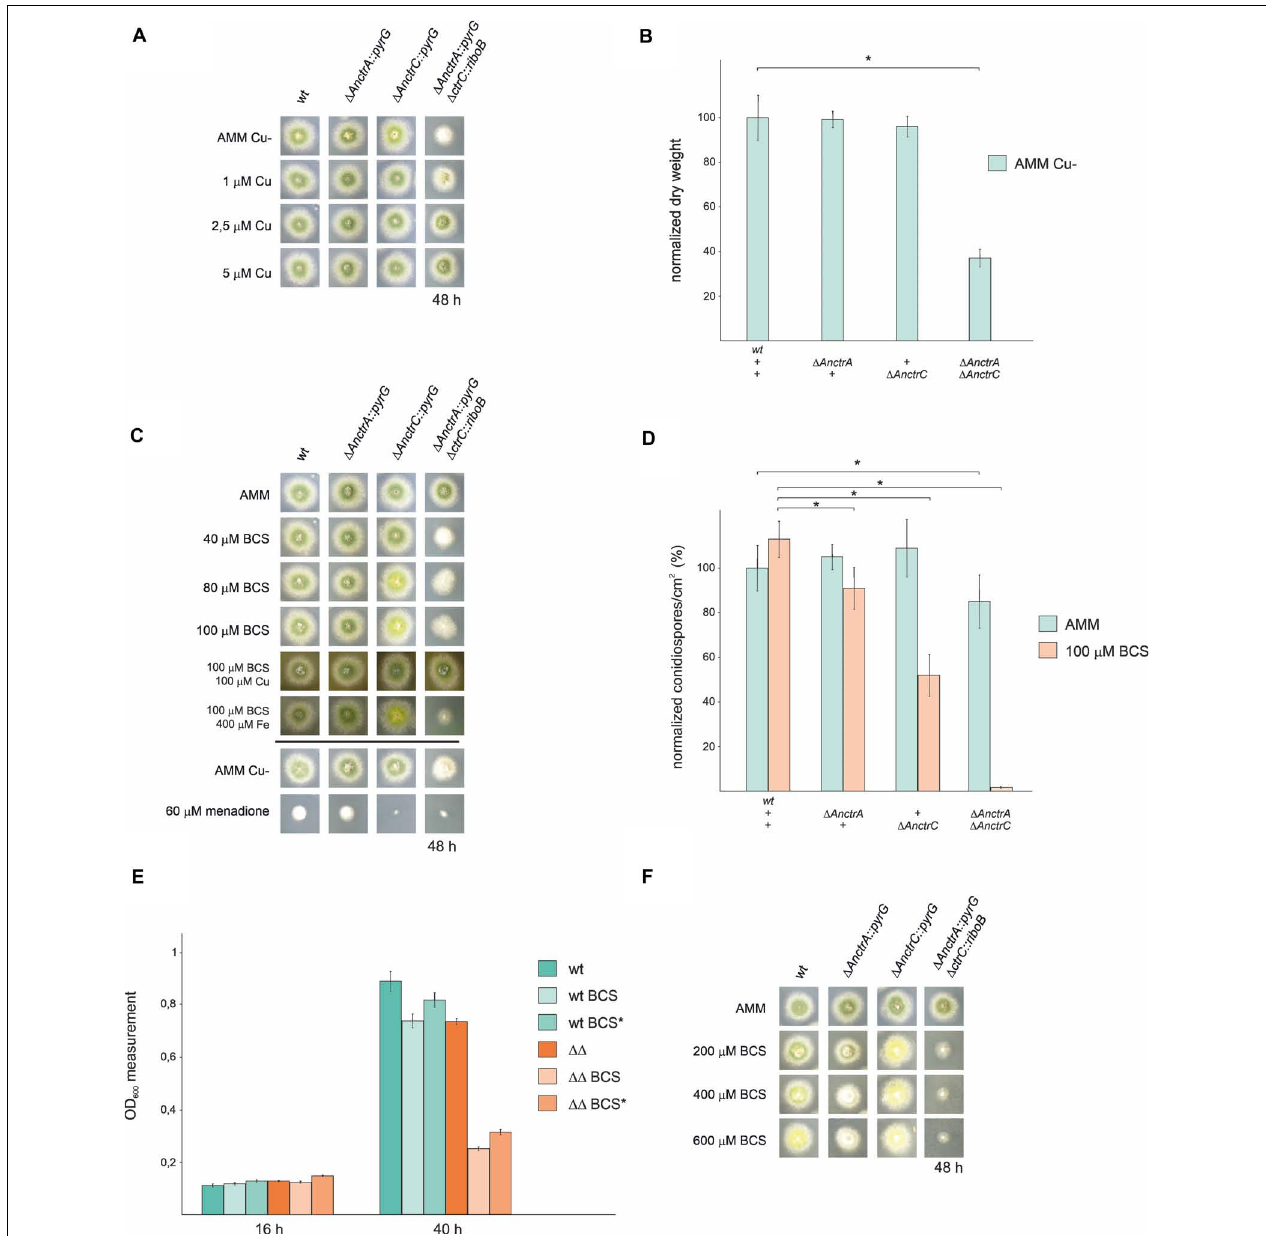
FIGURE 4 | Functional analysis of AnctrA and AnctrC mutants. (A) Spores from the mutant strains were point-inoculated and images of colonies were taken after 48 h of incubation at 37 ◦ C in 0 µ M Cu AMM (Aspergillus minimal medium) and 0 µ M Cu AMM with 1, 2.5, and 5 µ M Cu. (B) Dry weight measurements of the mutant strains incubated for 16 h at 37 ◦ C in 0 µ M Cu AMM. (C) Spores from the mutant strains were point-inoculated and images of colonies were taken after 48 h of incubation at 37 ◦ C in AMM and AMM with 100 µ M CuSO4, 100 µ M BCS, 100 µ M BCS with 100 µ M CuSO4 and 100 µ M BCS with 400 µ M FeSO4. (D) Conidia production was determined by quantifying the number per unit of colony surface area (conidia/cm 2 ). In order to facilitate data comparison, growth of the wt strain at basal level was designated 100%, data was normalized and presented as percentages.*Significant conidiospore number reduction p < 0.05. (E) In liquid medium culture experiments, 6 × 10 4 spores of the WT and (cid:49) AnctrA (cid:49) AnctrC strains were inoculated for 16 h and 40 h at 37 ◦ C, under basal conditions (MMA), low copper availability conditions (BCS) and low copper availability conditions after 16 h of normal growth (BCS*). (F) Spores from the mutant strains were point-inoculated and images of colonies were taken after 48 h of incubation at 37 ◦ C in AMM and AMM with 200, 400, and 600 µ M BCS.